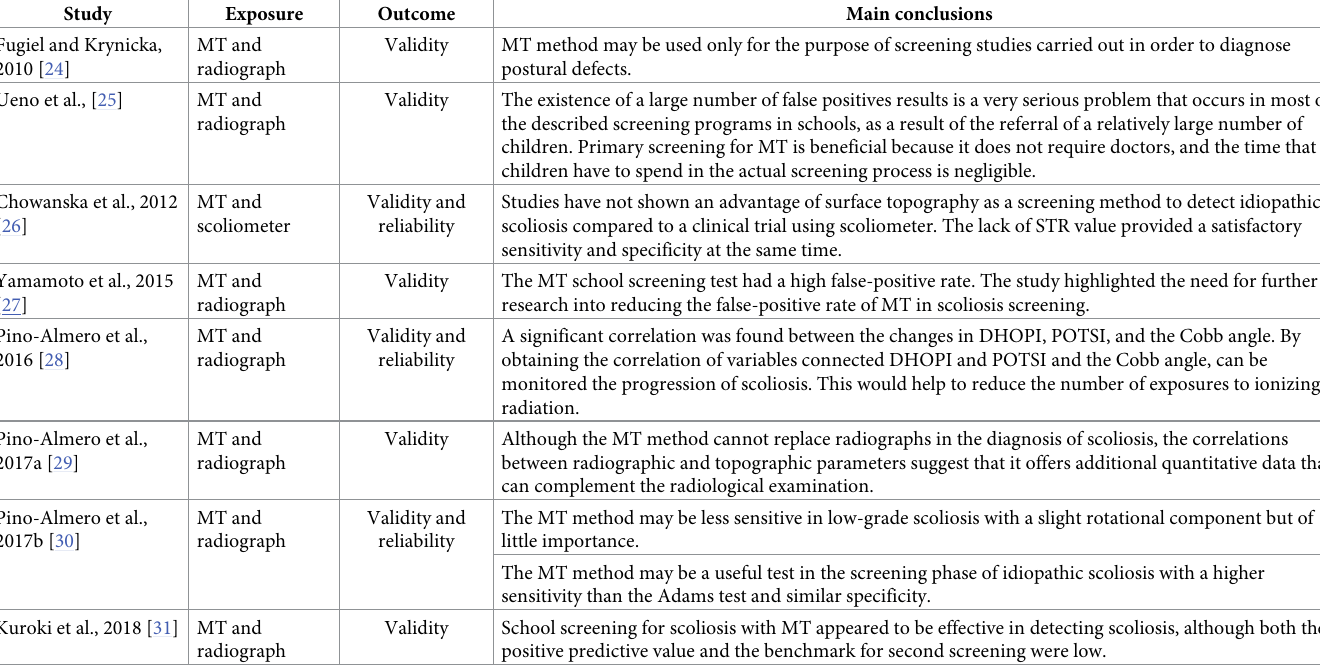
Table 4. Main conclusions from studies included in the systematic